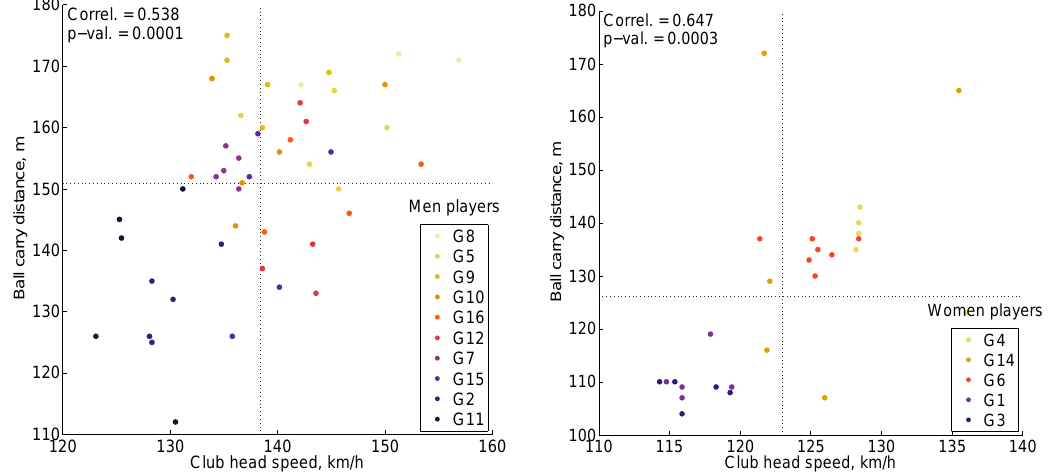
Figure 2. Scatterplot, showing the effectiveness for men ( Left ) and women ( Right ) players. Notes: grid lines correspond to sex-specific averages; shots are colored according to the player’s overall effectiveness, where a lighter color means a more effective player, based on average club head speed and average ball carry distance through all of his/her